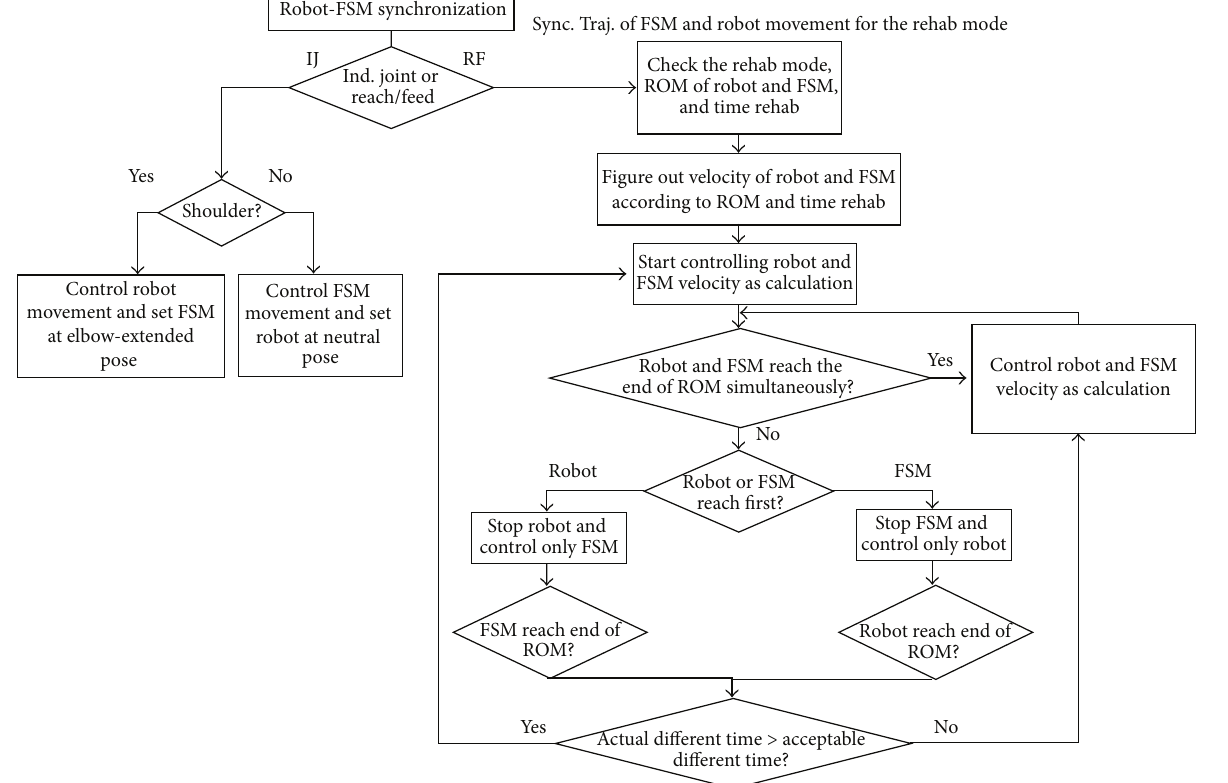
Figure 5: Synchronization procedures between IC, FSM, and